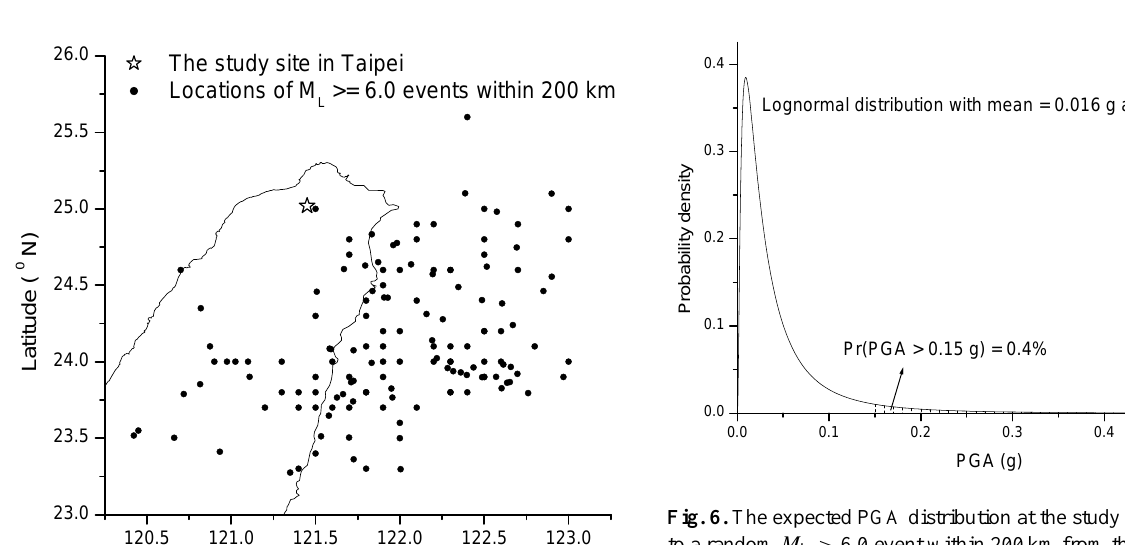
1900, the mean values and standard deviations of magni- tude are M L = 6.44 and 0.46, and they are 129 and 39 km for source-to-site distance. Table 1 summarizes the inputs for the analysis, including earthquake rates, magnitude/distance thresholds, and the uncertainties ( ε and ε M ) of two empirical